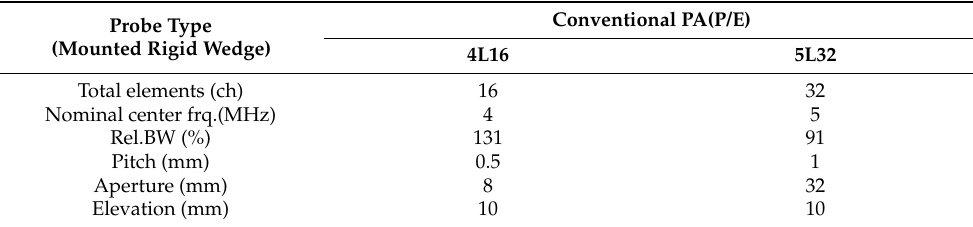
Table 4. Specifications of the commercially available PA probes mounted on rigid solid wedges.